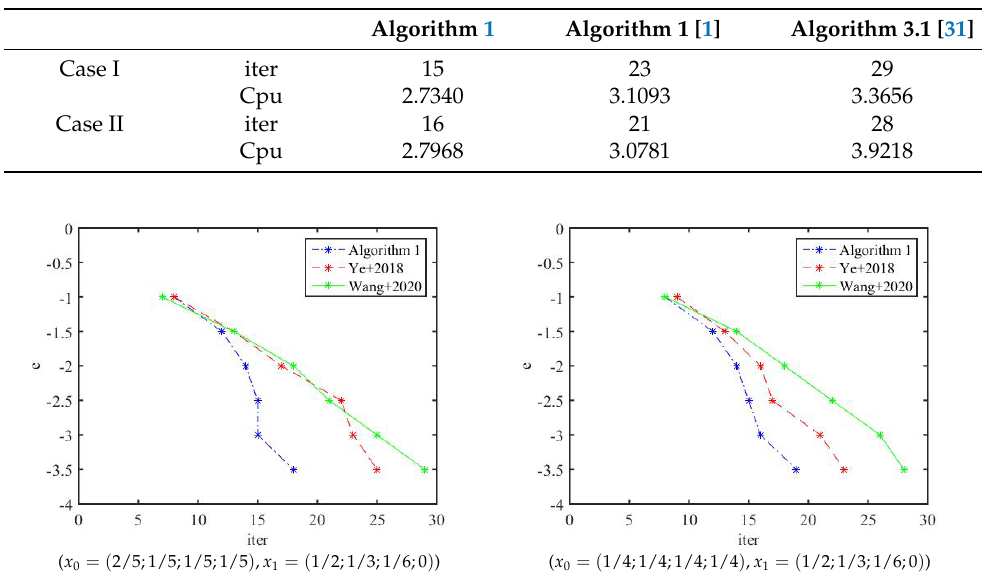
Figure 1. Comparison of iteration times of Algorithm 1, Algorithm 1 [1] and Algorithm 3.1 [31] at different initial points under T = T 2 in Example 2.